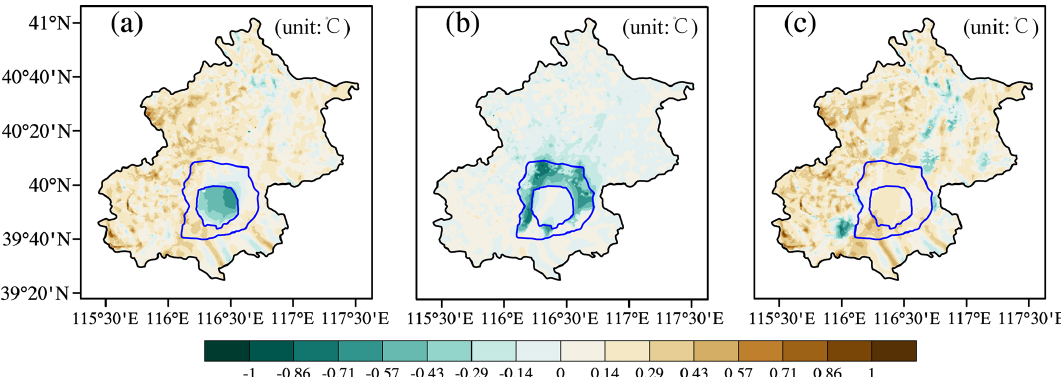
Figure 9. Cooling effects in the city center (a) , suburbs, (b) and rural areas (c) due to road sprinkling in the night. The amount of water was half the maximum water-holding capacity of the urban impervious